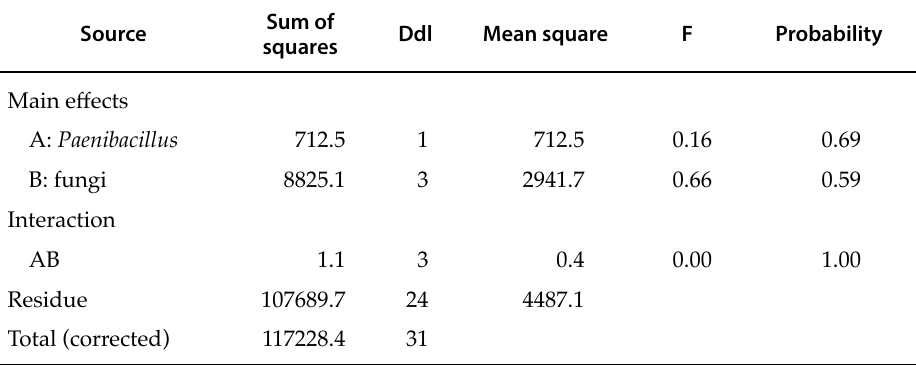
Table 6. ANOVA for “Root dry weight” in mg - type III Sum of squares Sum of Ddl Mean square F Probability Source squares Main effects